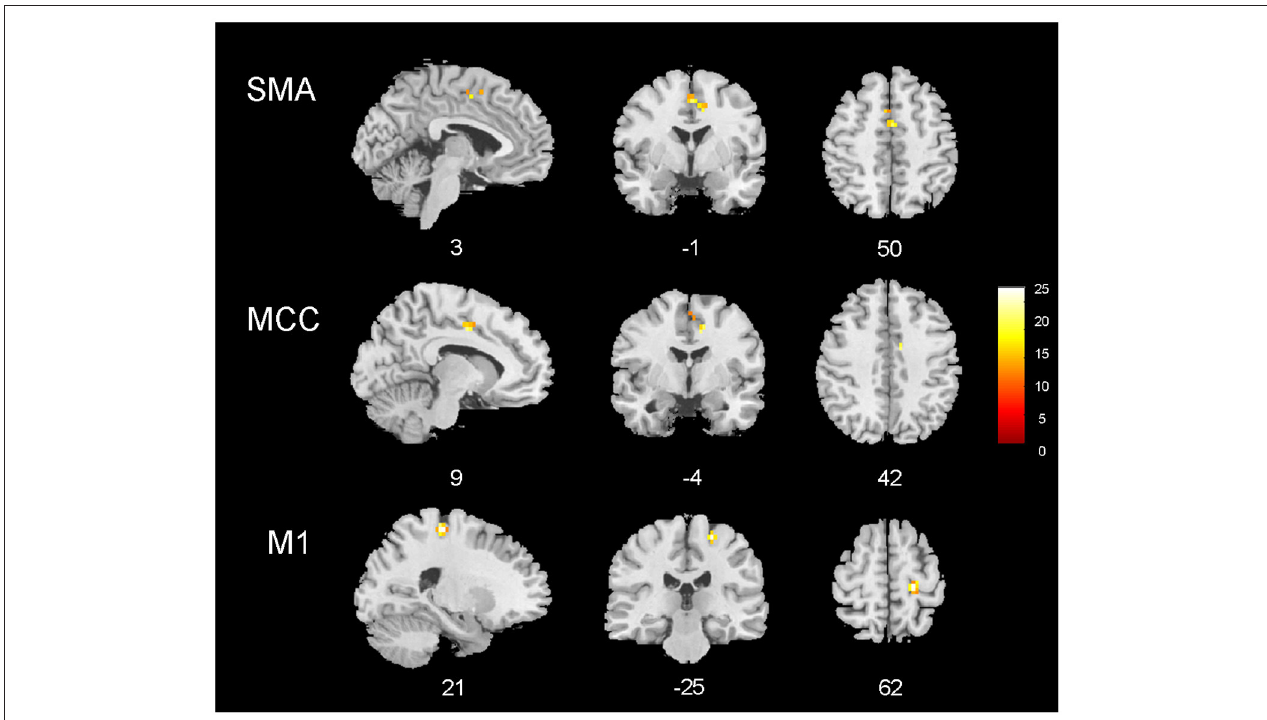
FIGURE 3 | EEG–fMRI group analysis in 25 patients with temporal lobe epilepsy. Results of the group analysis (cluster size threshold K > 15, corrected at α < 0.05). Clusters are shown in sagittal, coronal, and axial slices of an anatomical template found in the xjview toolbox (https://www.alivelearn.net/xjview). Color bar represents t